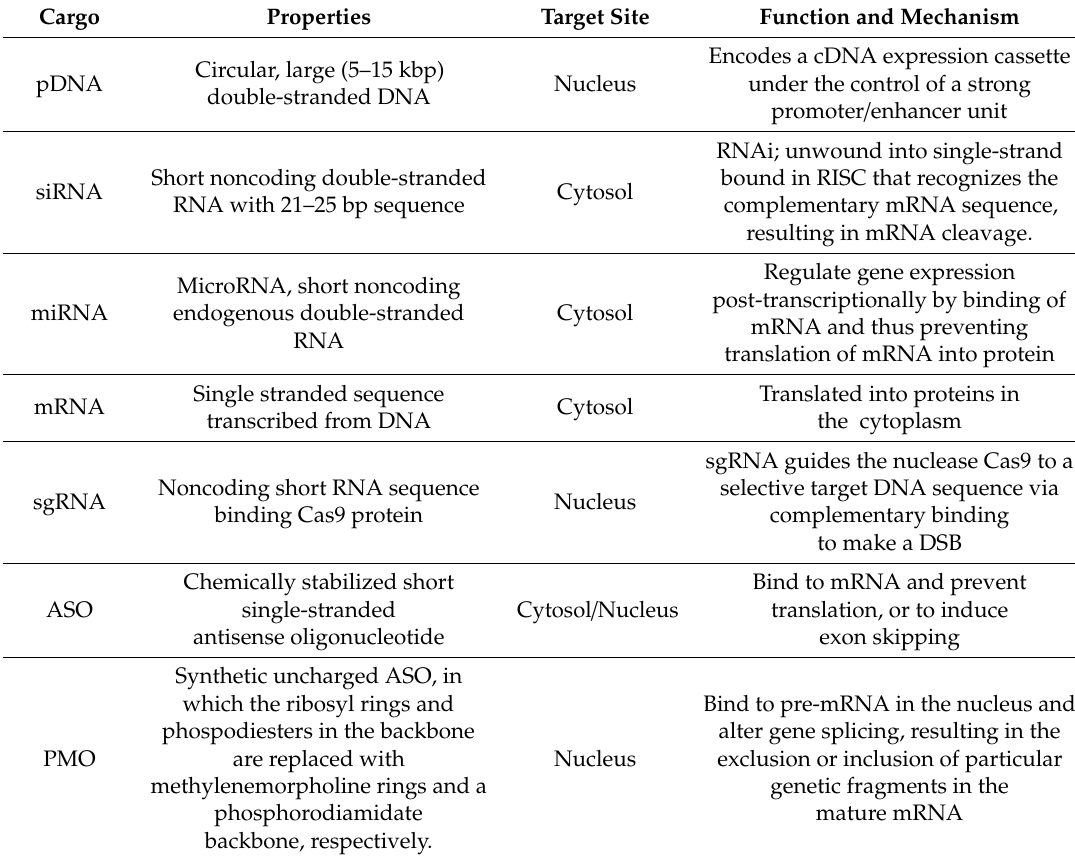
Table 1. Properties of therapeutic nucleic